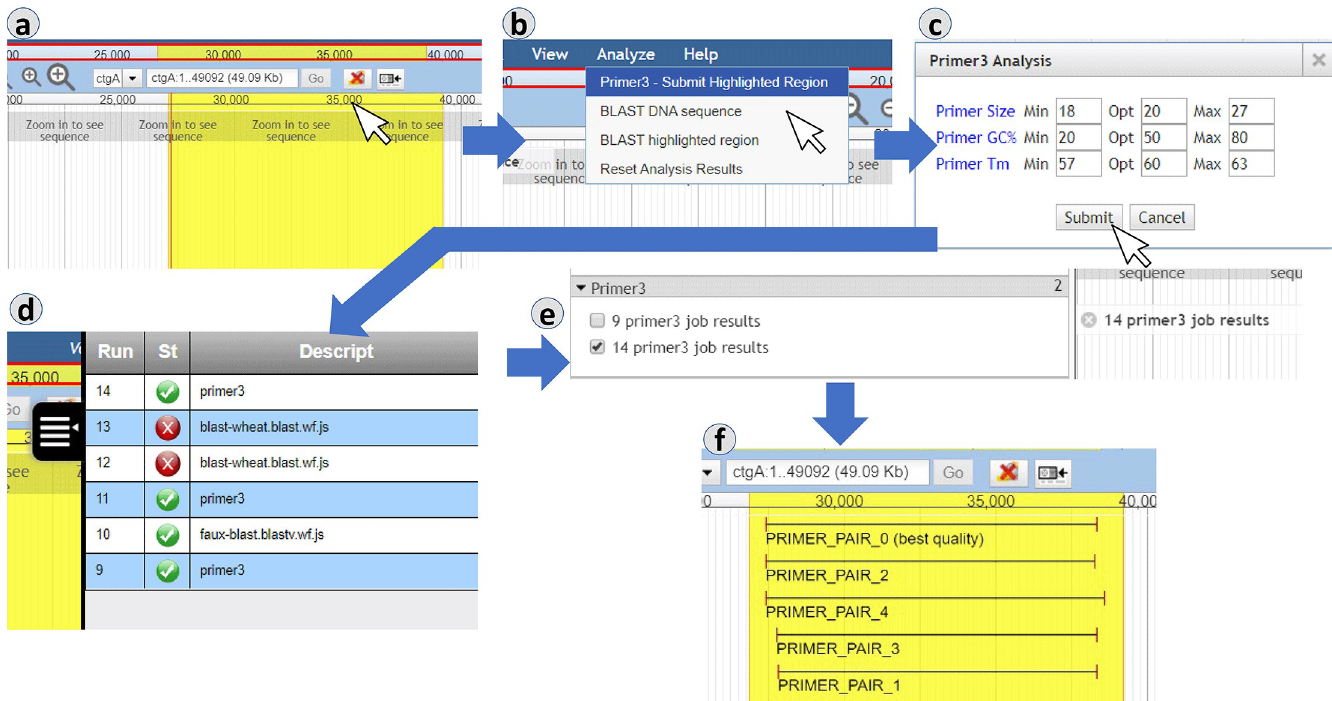
Fig 6. The Primer3 user interface involves selecting a region, then submitting it for processing. The job can be tracked using the built-in queue view. The returned primer pairs are displayed as genome features. Panels: (a) selection by highlighting, (b) running Primer3 via menu, (c) Primer3 analysis dialog, (d) job queue, (e) Primer3 results tracks, (f) Primer3